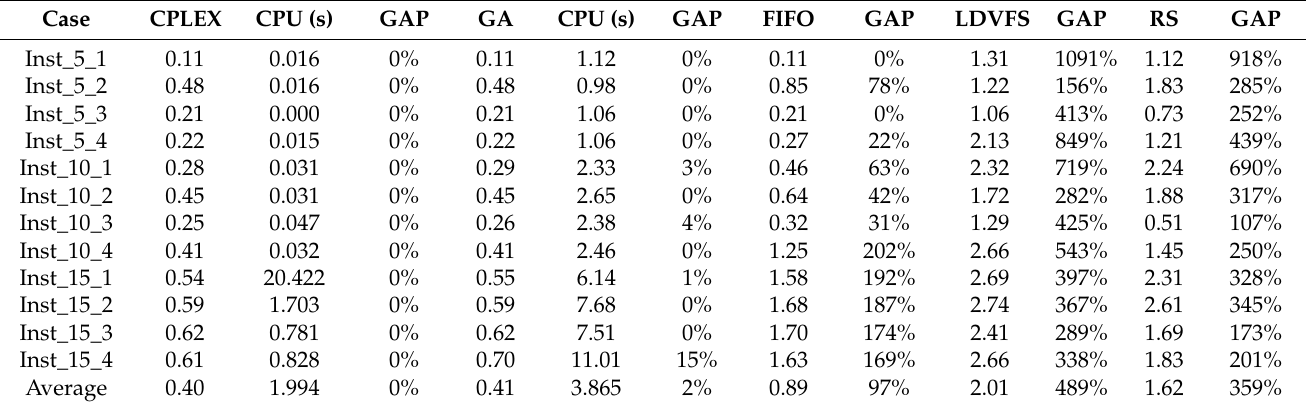
Table 13. Comparisons between CPLEX, FIFO, LDVFS, RS, and